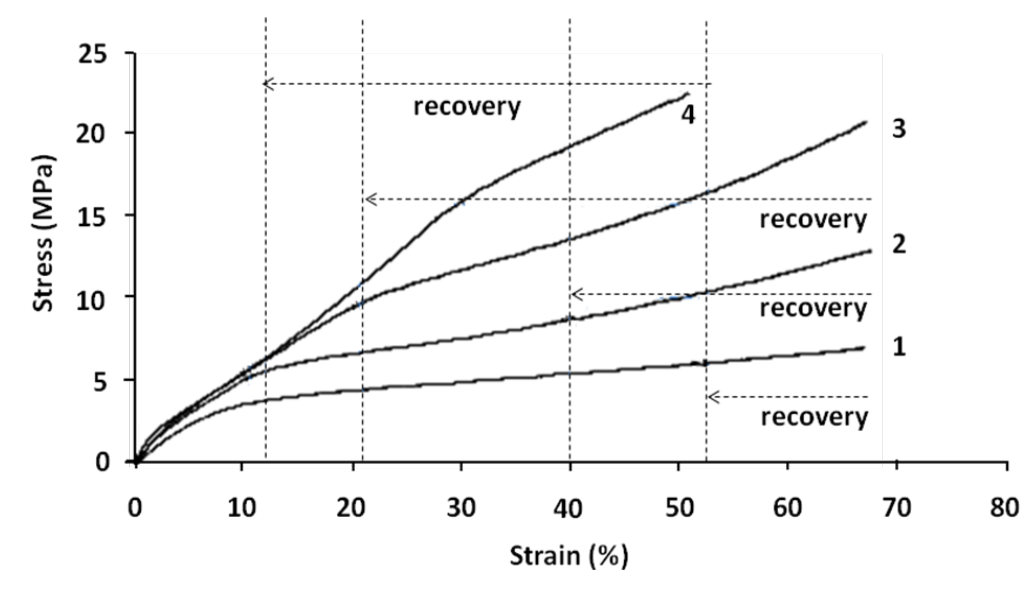
Figure 8. Real stress versus real strain (tensile tests) at the beginning of each cycle of shape memory tests at 70 °C. ( 1 ) First cycle; ( 2 ) Second cycle; ( 3 ) Third cycle; and ( 4 ) Fourth